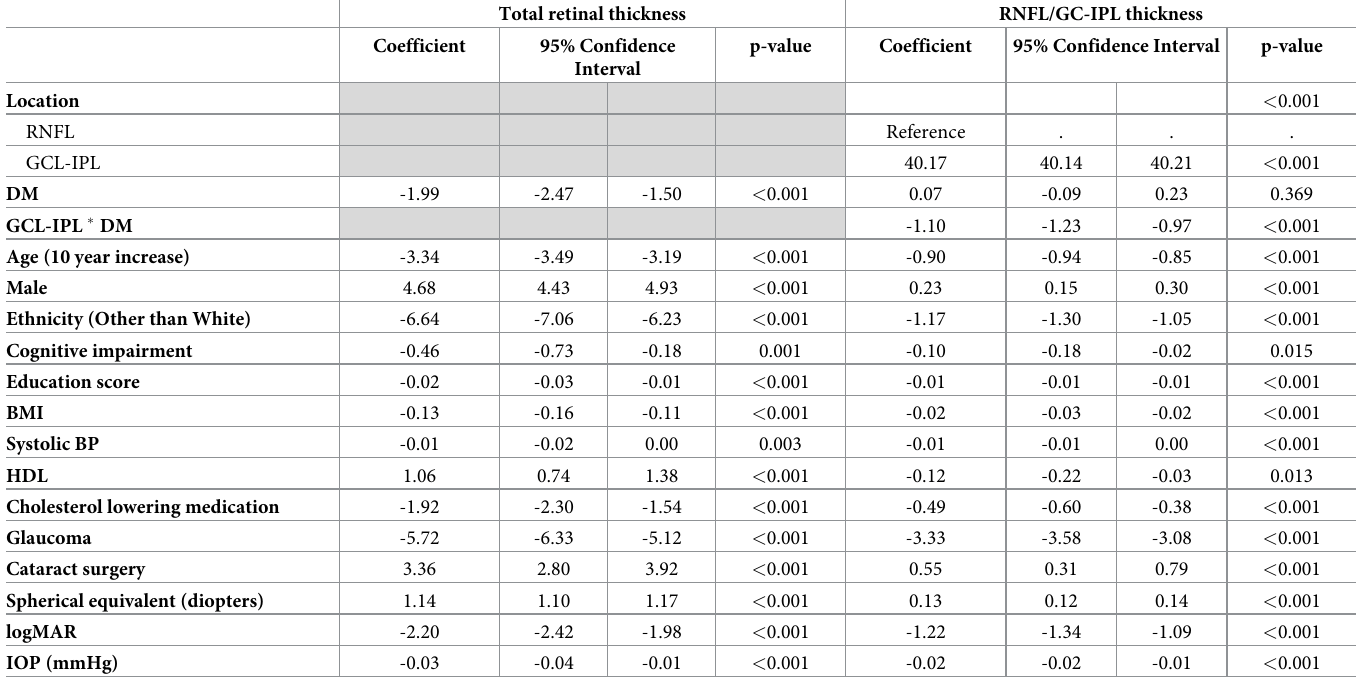
Table 3. Multivariable general linear mixed models for retinal thickness